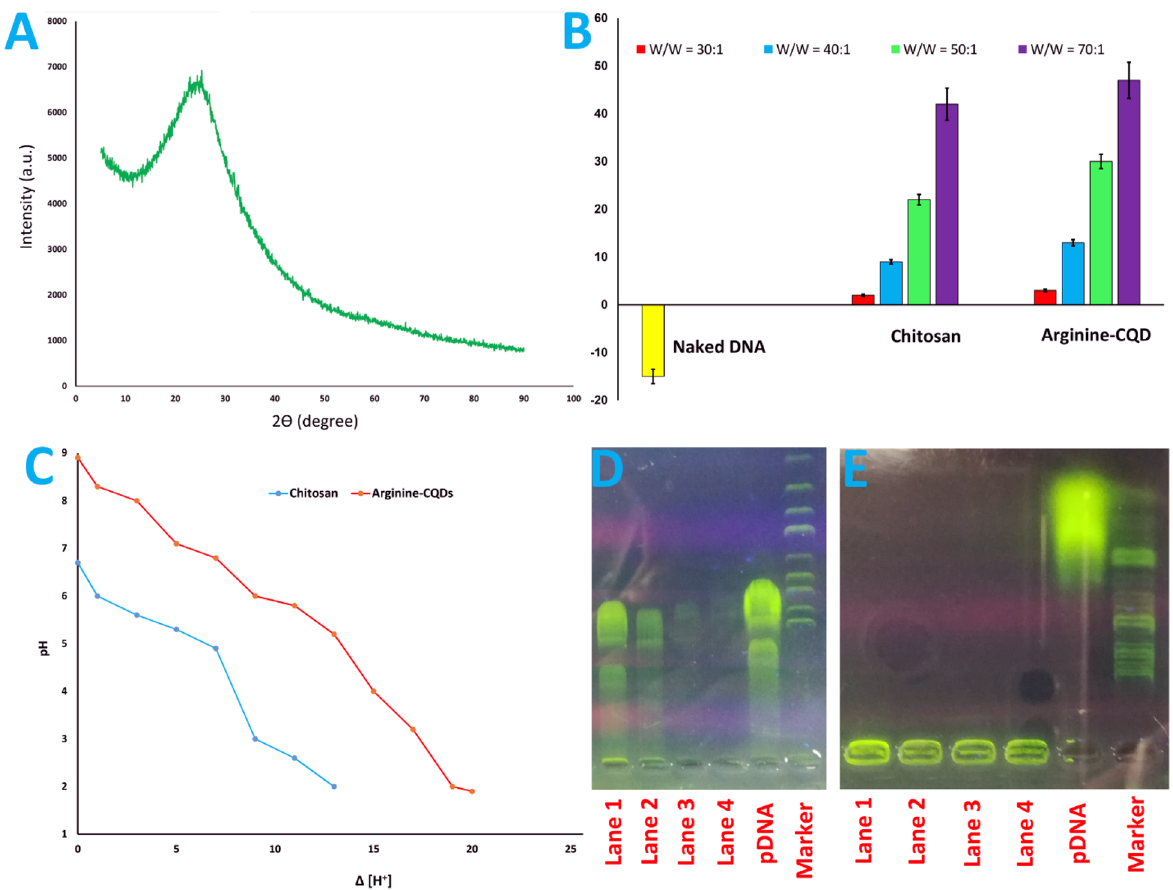
Figure 4. ( A ) The XRD pattern of Arginine-CQDs, ( B ) zeta potential of naked DNA, chitosan, and Arginine- CQDs, ( C ) buffering capacity of chitosan and Arginine-CQDs, ( D ) gel retardation assay of chitosan, ( E ) gel retardation assay of Arginine-CQDs, at various weight ratio. Lane 1, W/W = 30; Lane 2, W/W = 40; Lane 3, W/W = 50; Lane 4, W/W = 70; Lane 5, pDNA; Lane 6, DNA